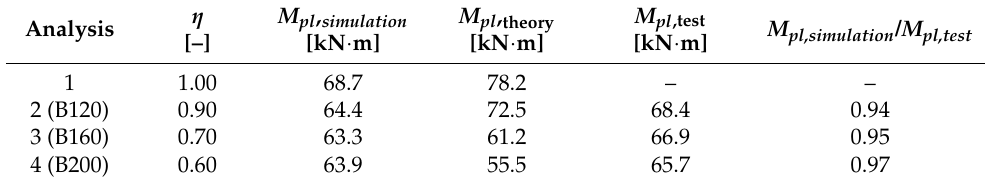
Table 6. The plastic resistance to sagging bending of the aluminium–timber composite beams.